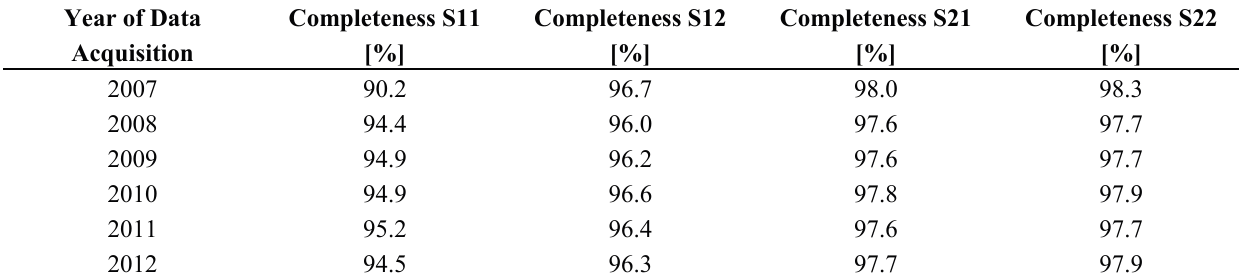
Table A2. Mean completeness values of the blocks using different strategies for the different years of image acquisition (S11: 1st nadir stripe/“ADS steep”, S12: 1st nadir